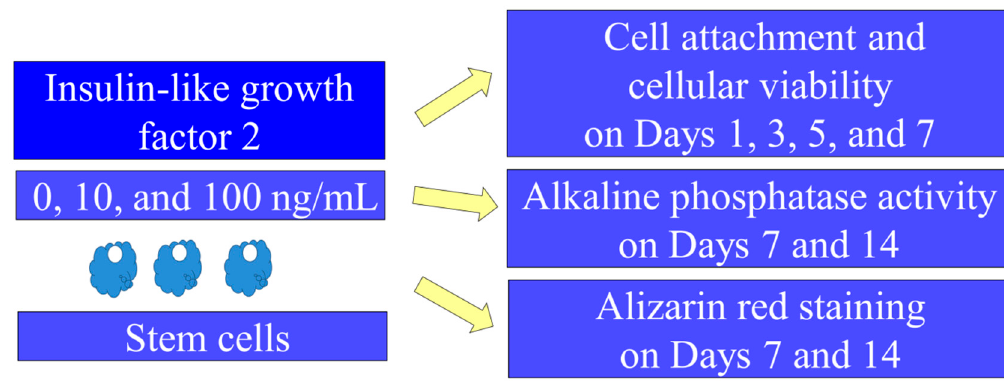
Figure 1. Overview of study design.